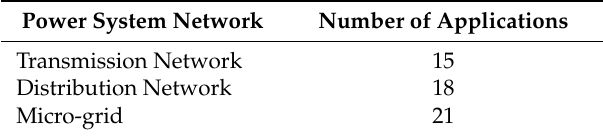
Table 4. Distribution of empirical studies by power system network.